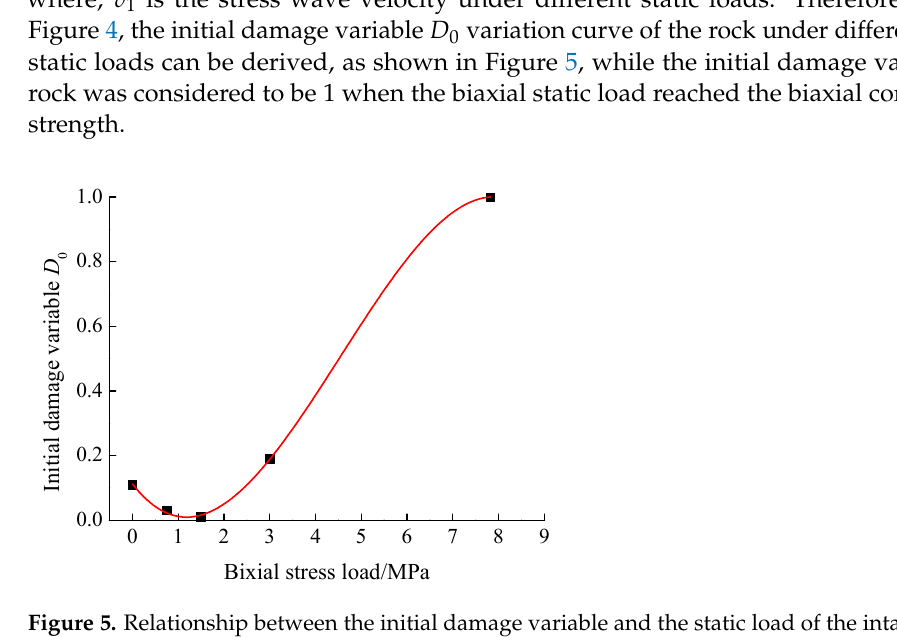
Figure 5. Relationship between the initial damage variable and the static load of the intact rock. Based on the five data samples in Figure 5, including four experimental data points and one data point that characterized the failure of the intact rock obtained by mechanical analysis, the fitting equation was obtained by the least square polynomial fitting as shown in Equation (4), and the adjusted R-square and residual sum of squares of the equation were 0.994 and 1.034 × 10 − 4 , respectively.